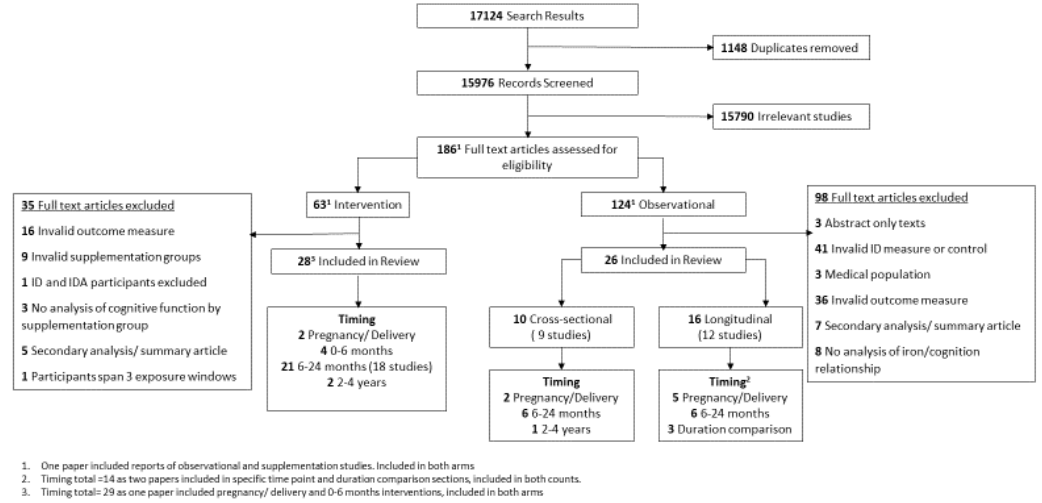
Figure 1. PRISMA flowchart of studies included in the review.